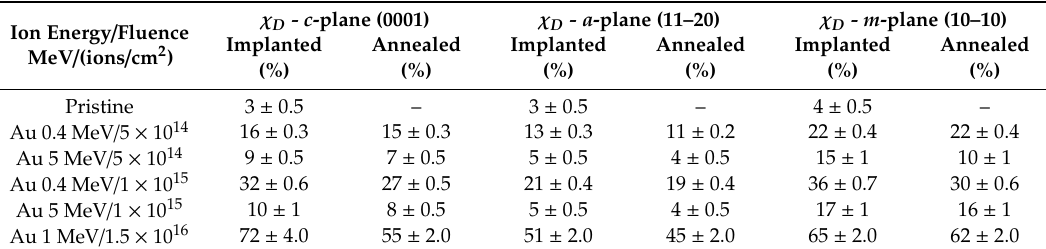
Table 3. The minimum yield ( χ D ) is presented for as-implanted and as-annealed samples for all crystallographic orientations of ZnO samples. The values were obtained from RBS / C analysis after Au-ion implantation with various energies and fluences